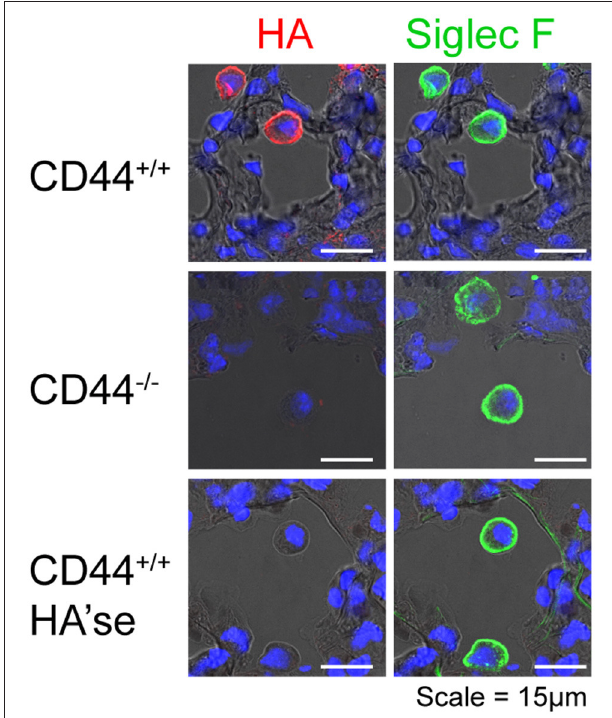
FIGURE 1 | CD44 + / + AMs, but not CD44 − / − AMs, have a HA coat. Frozen lung sections from CD44 + / + and CD44 − / − mice were obtained and labeled with HABP to detect HA (red), and Siglec F, a marker of AMs (green), and cell nuclei identified by DAPI (blue). In the lower panel, the sections were treated with bovine testicular hyaluronidase (HA’se). Top and bottom row are lung sections from CD44 + / + mice, and the middle row is from CD44 − / − mice. Images were captured on a Leica SP5 scanning laser confocal microscope, under identical acquisition settings. Images are representative of those published in Dong et al.